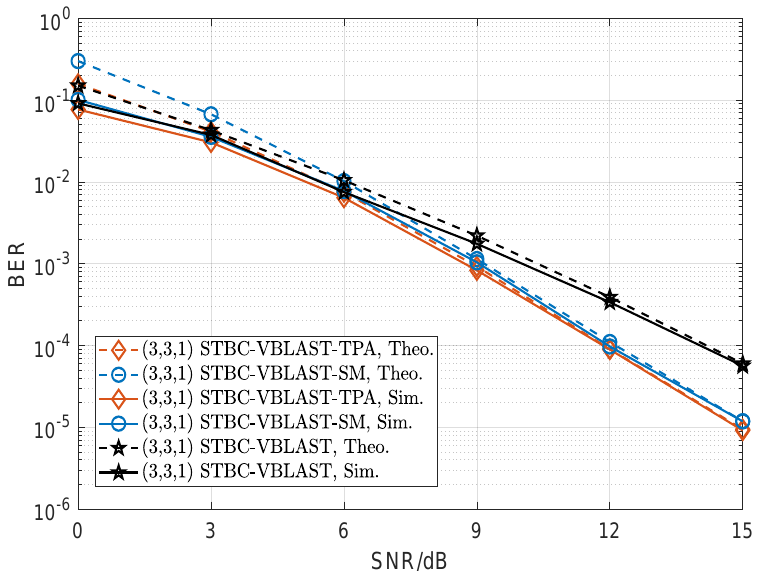
Figure 9. Performance comparisons of the ( 3,3,1 ) STBC-VBLAST-SM system, STBC-VBLAST-TPA system and traditional STBC-VBLAST system, where 2.5 bits/s/Hz for the STBC-VBLAST-SM system and 2 bits/s/Hz for the STBC-VBLAST-TPA and STBC-VBLAST systems.